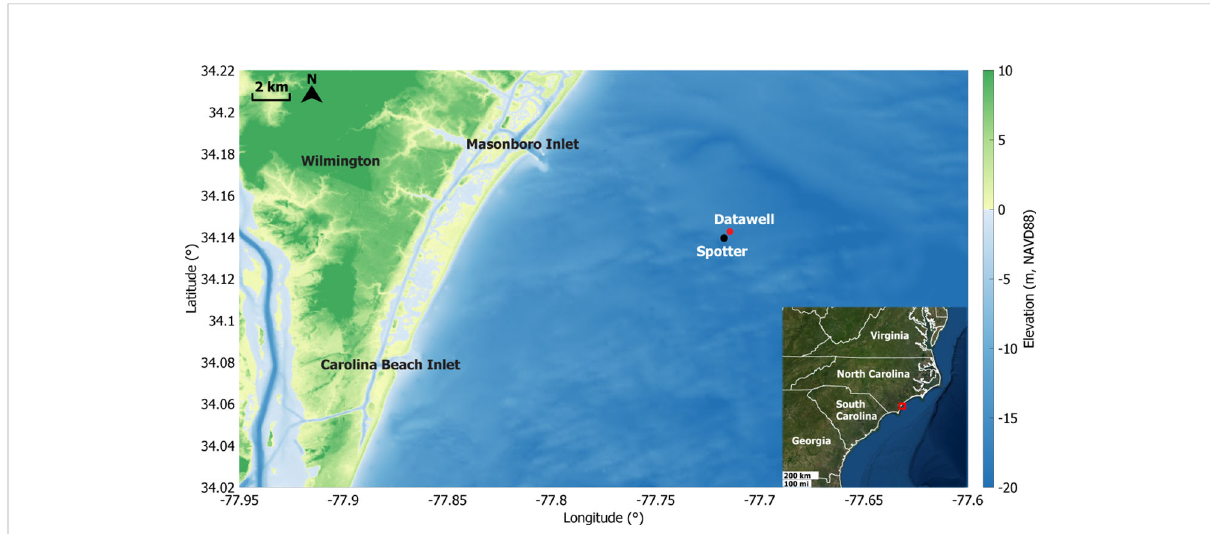
FIGURE 1 Location of the Datawell and Spotter wave buoys offshore of Masonboro Inlet, North